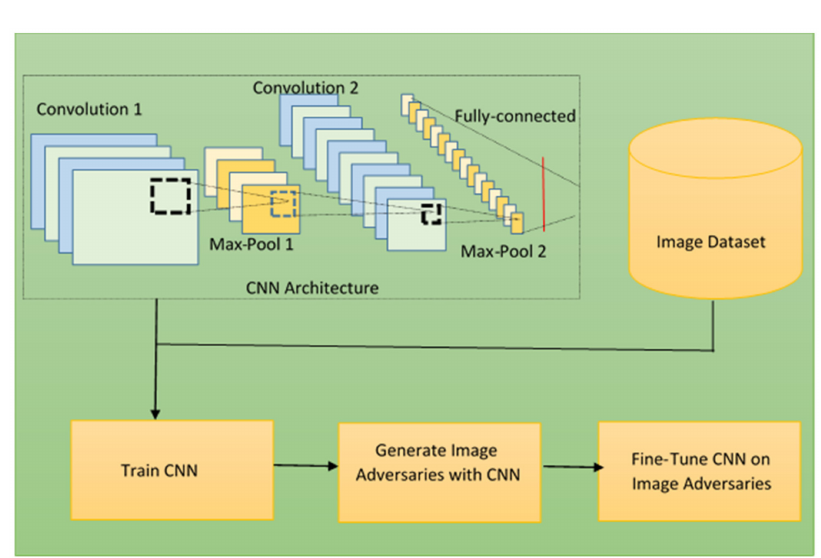
Figure 7. The basic workflow of the adversarial defense